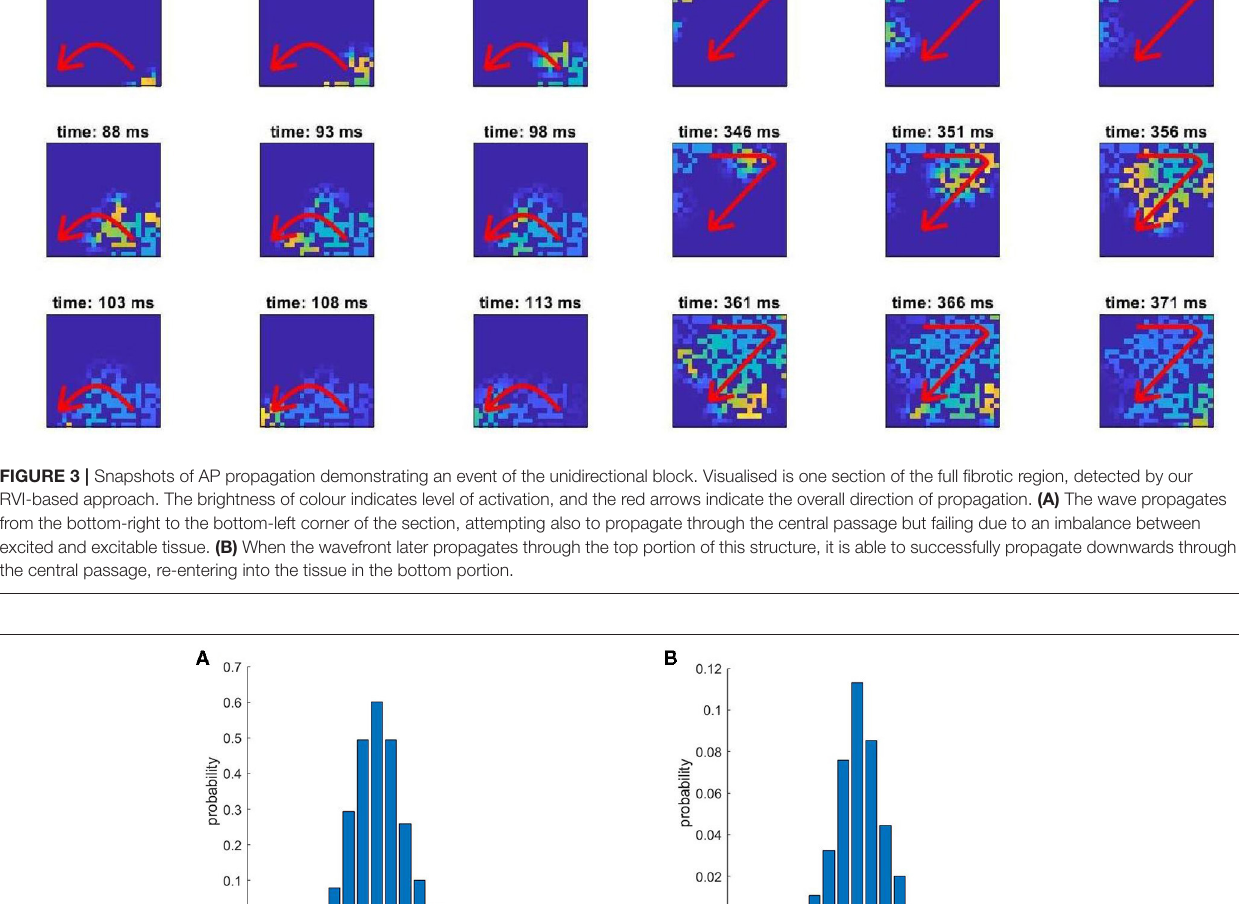
Frontiers in Physiology |